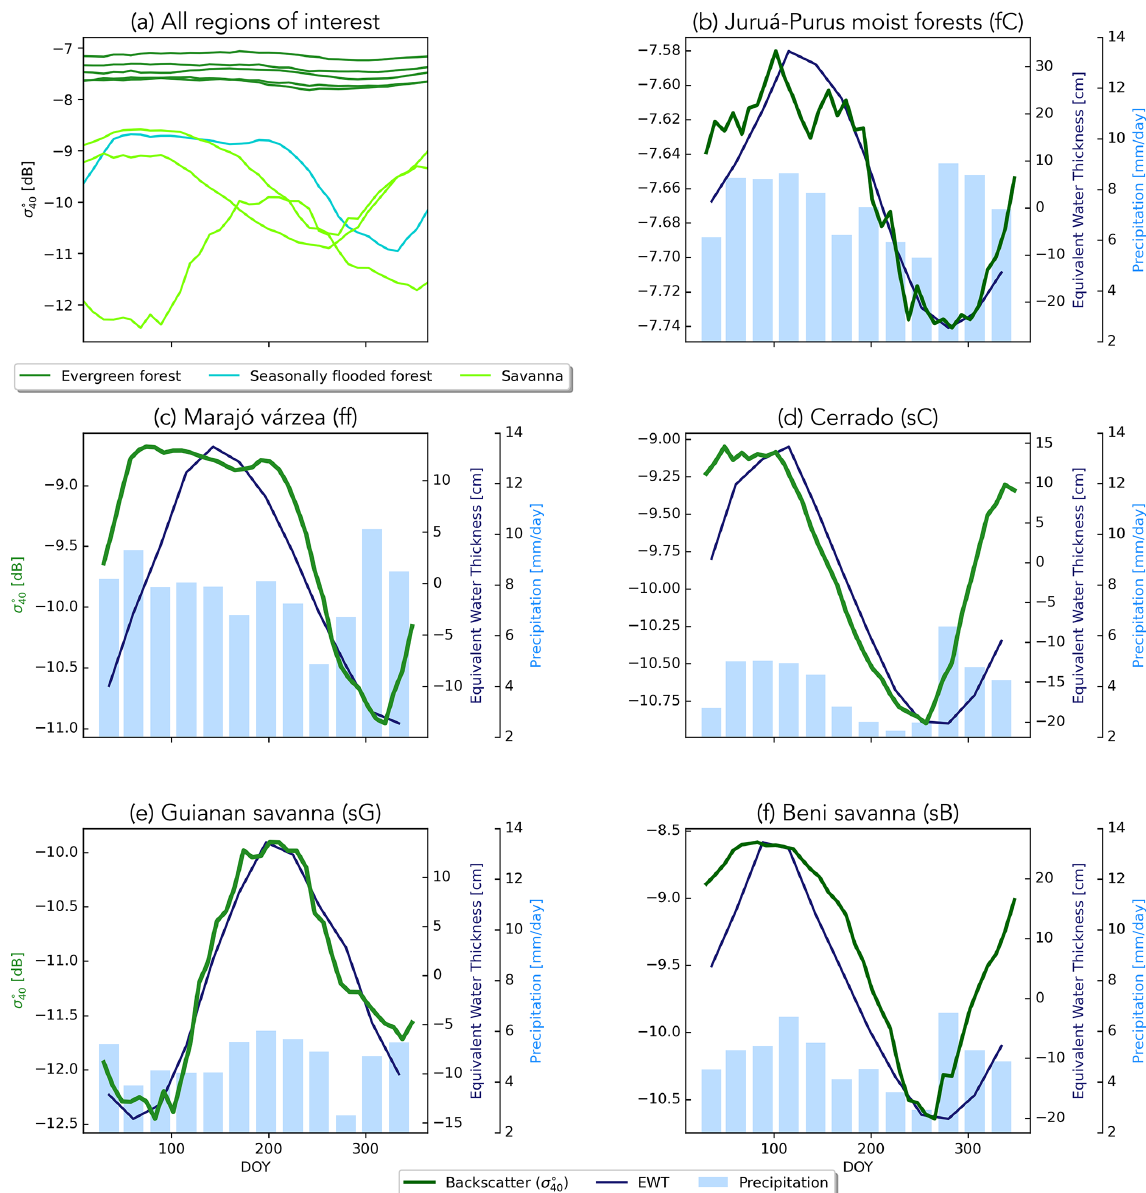
Figure 4. Climatologies of backscatter for all ecoregions, with five evergreen forests (dark green), flooded forests (cyan), and three sa- vannas (light green) (a) . Panels (b) – (f) show the climatology of backscatter (green line) with precipitation (bars) and equivalent water thickness (EWT; blue line) per ecoregion. Note the different y axes and that only the Juruá–Purus moist forest (fC) is shown, as it is similar to the other evergreen